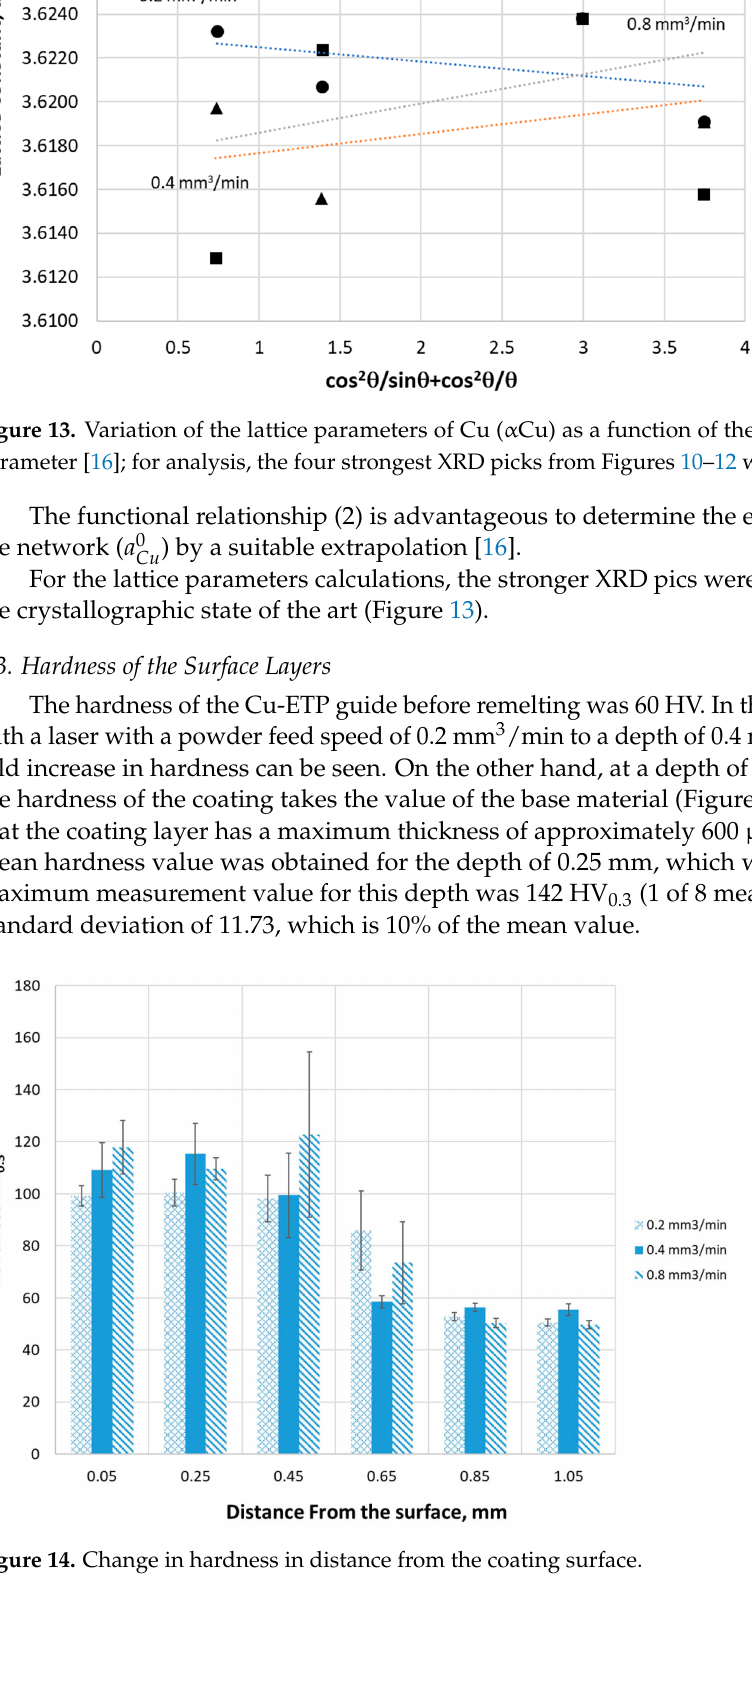
11 of 22 Figure 12. X-ray di ff raction pa tt ern for the qualitative CrAl coating on copper Cu-ETP, powder feed rate 0.2 mm 3 / min. Figure 13 shows the change of the Cu (aCu) matrix la tt ice parameter of Cu-ETP as a function of the Nelson–Riley (N-R) parameter for the respective peaks obtained from the XRD analysis of the test samples: (cid:4678)𝑐𝑜𝑠 (cid:2870) 𝜃